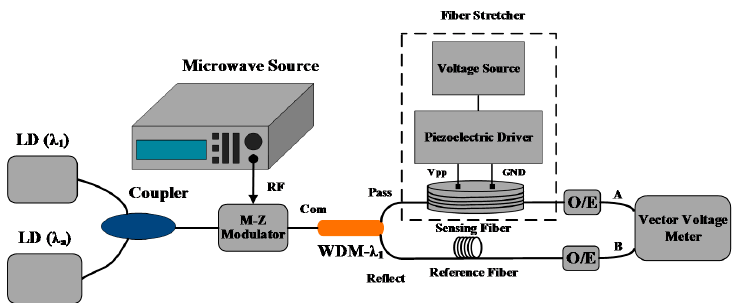
Figure 4. The schematic structure of a fiber-optic delay-based strain sensor.